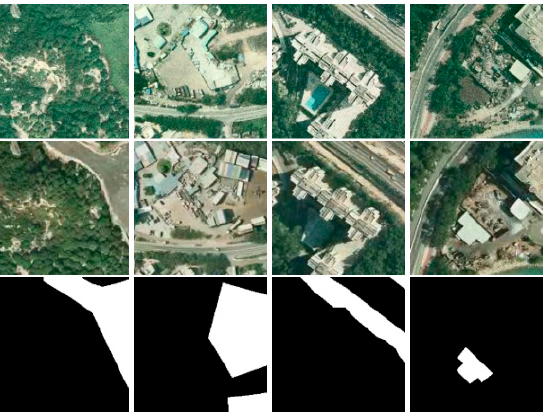
Figure 5. Image patch examples and corresponding reference images of the SYSU-CD data set.